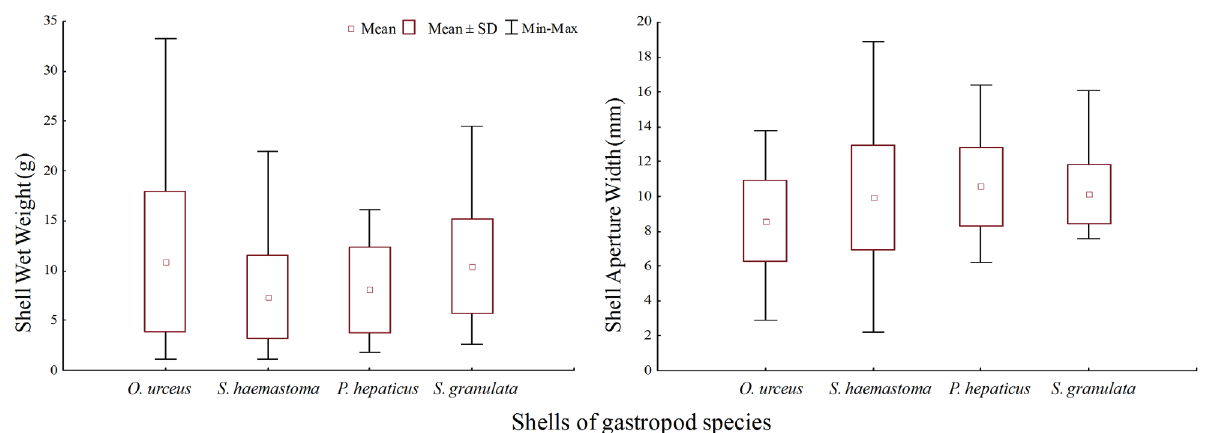
Figure 2. Mean values and standard deviation of Shell Wet Weight and Shell Aperture Width of the four most abundant gastropod species ( Olivancillaria urceus , Stramonita haemastoma , Polinices hepaticus and Semicassis granulata ) during the study period in an area adjacent to Babitonga Bay, Santa Catarina, Brazil.